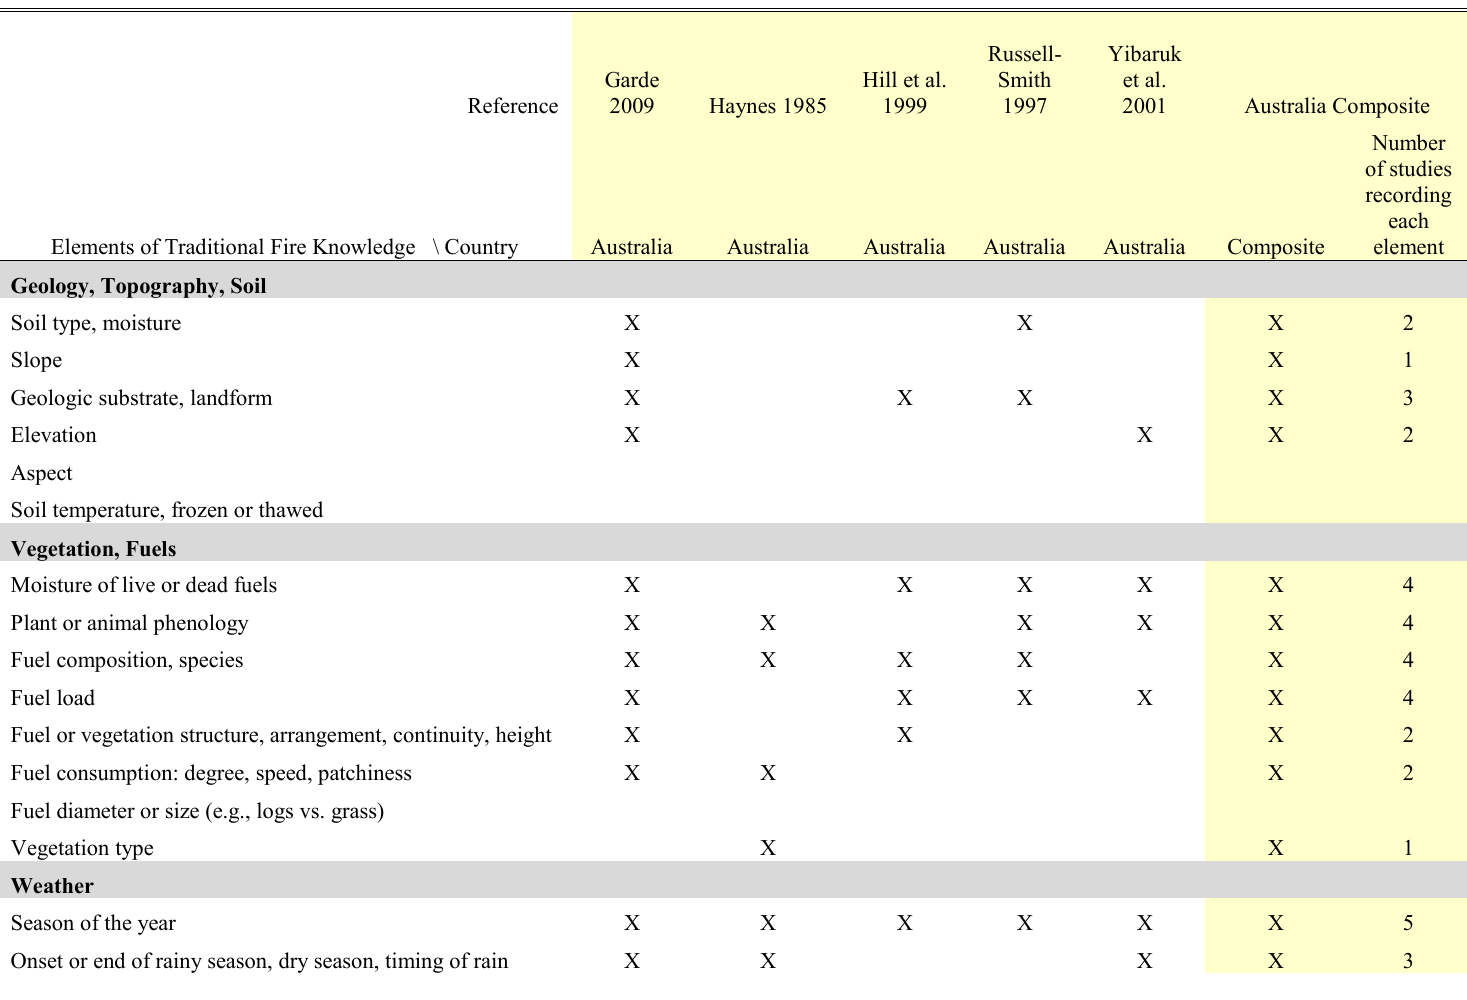
Table A.3. Elements of traditional fire knowledge recorded in studies from Australia